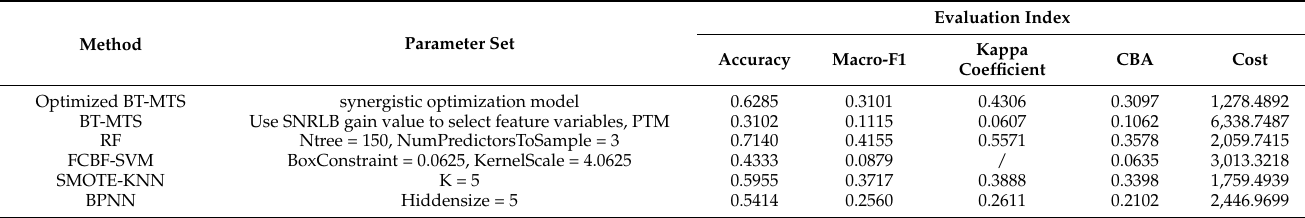
Figure 5. Comparison of DRR of the Wine quality-white data set. The balance data set comparison results of the six methods are presented in Table 9. Table 9. Comparison of the classification results of the Wine quality-white data set.